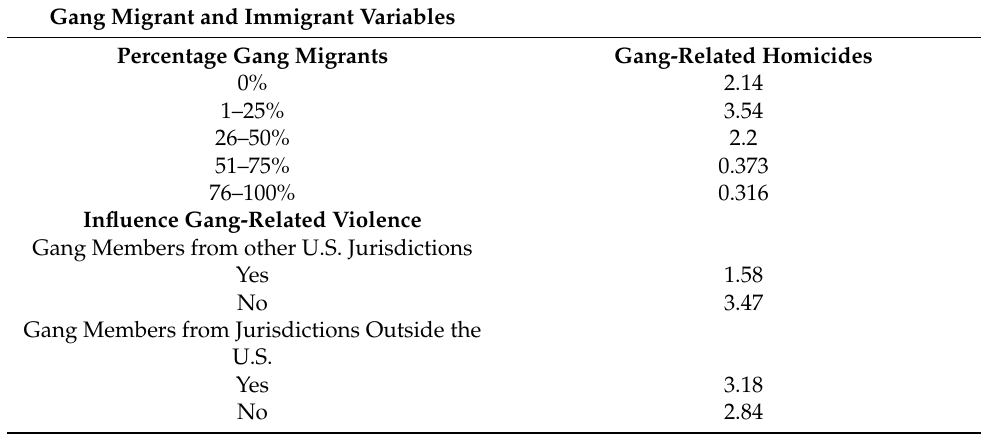
Table 2. One-Way ANOVA Results and Mean Frequency of Gang-Related Homicides (n = 741). Gang Migrant and Immigrant Variables Percentage Gang Migrants Gang-Related Homicides 0% 2.14 1–25% 3.54 26–50% 2.2 51–75% 0.373 76–100% 0.316 Influence Gang-Related Violence Gang Members from other U.S. Jurisdictions Yes Gang Members from Jurisdictions Outside